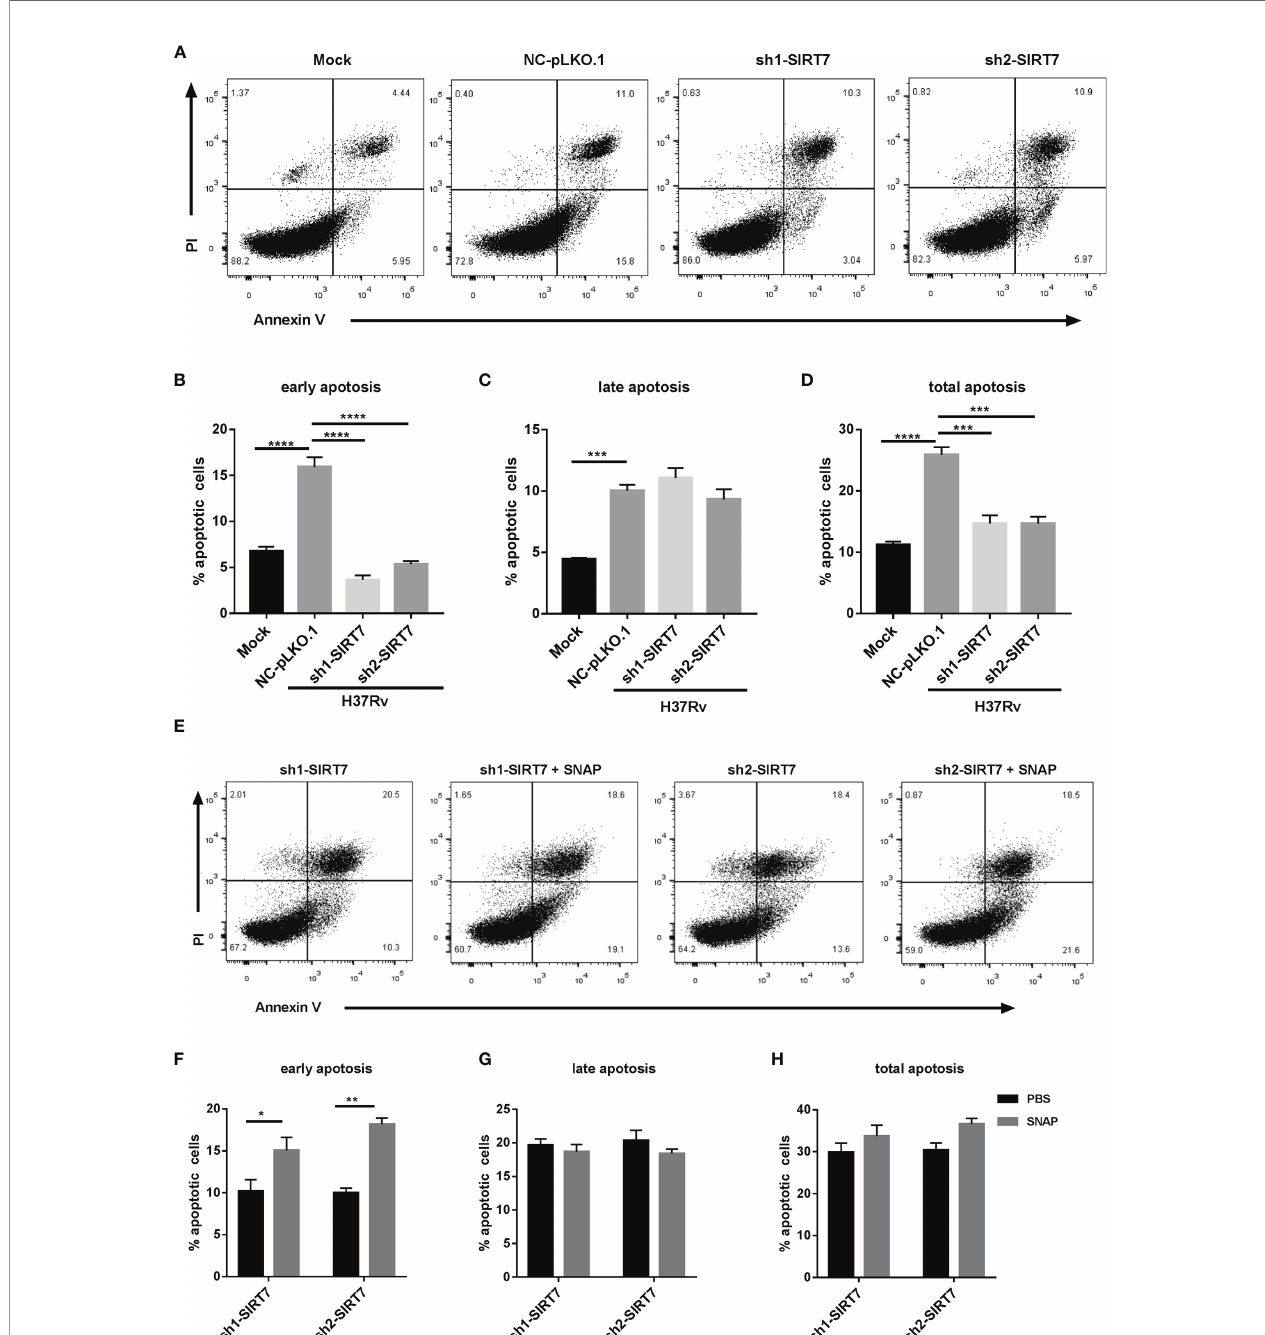
FIGURE 7 | SIRT7 promotes elimination of intracellular Mycobacteria by nitric oxide-dependent apoptosis. Scrambled control (NC-pLKO.1) and SIRT7-knockdown (sh1-SIRT7 and sh2-SIRT7) Raw264.7 cells were infected with H37Rv and apoptosis was detected by Annexin V and propidium iodide (PI) staining. (A, E) Representative fl ow cytometry images of apoptotic cells. (B – D) Percentage of apoptotic cells (early, late, and total, respectively) in the scrambled control and SIRT7-knockdown cells. (F – H) Percentage of apoptotic cells (early, late, and total, respectively) in the SIRT7-knockdown cells pretreated with or without SNAP (200 m M). The percentages of early, late, and total apoptotic cells were calculated by Flow Jo software. Data are representative of three independent experiments with similar results and are presented as means ± SD. Two way ANOVA was performed in (B – D) , One way ANOVA was performed in (F – H) . *p < 0.05; **p < 0.01; ***p < 0.001; ****p<